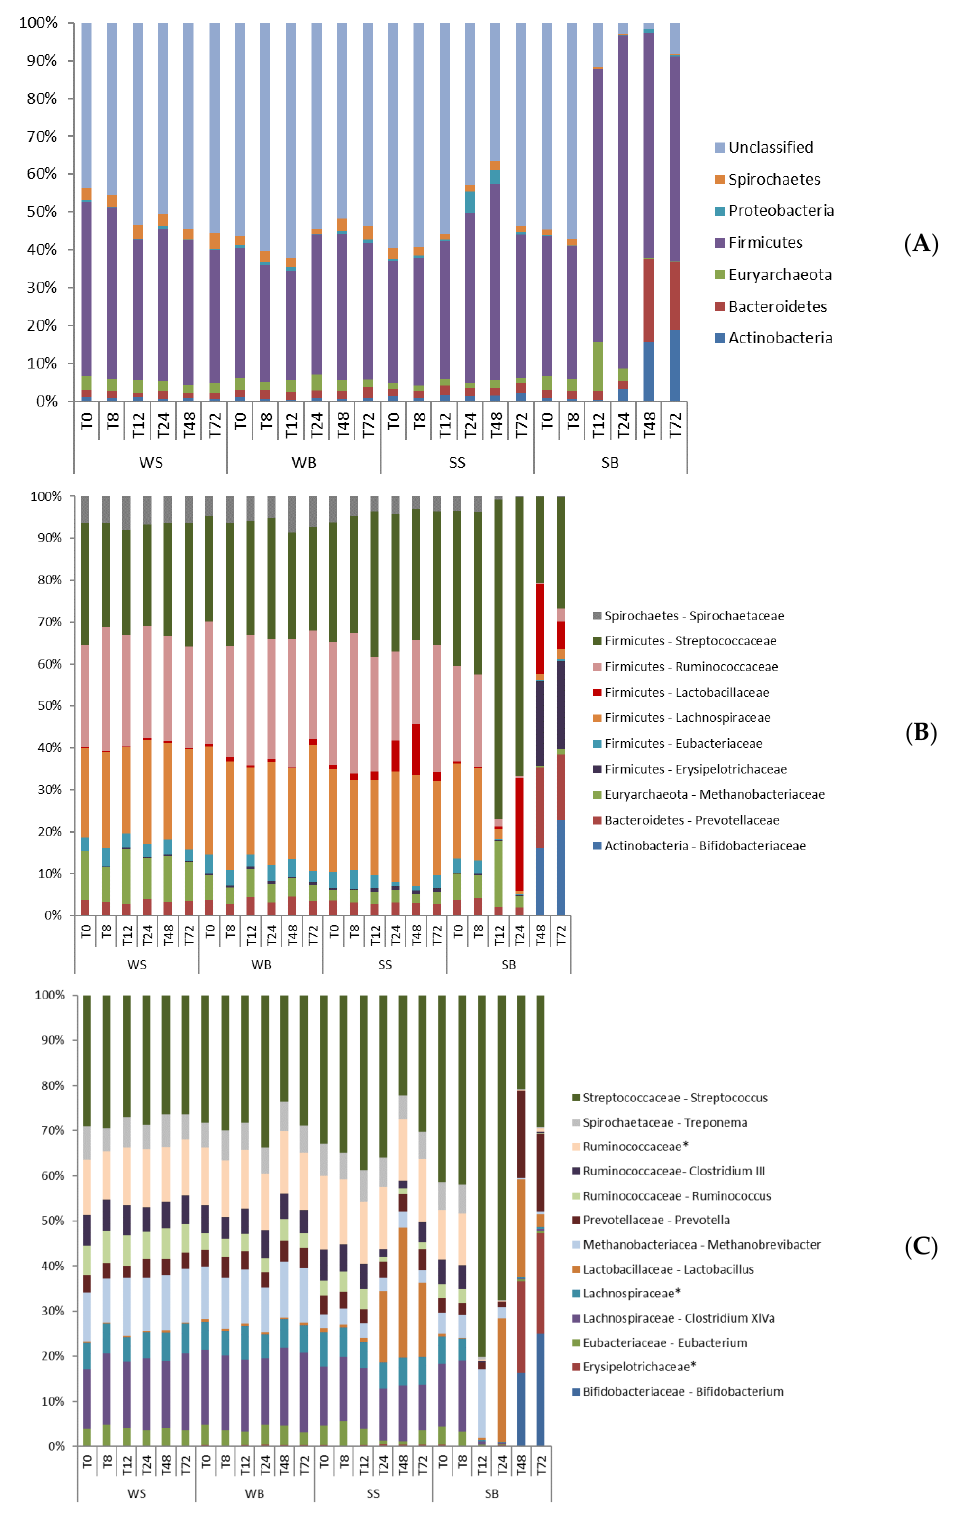
Figure 3. Relative abundance of the predominant bacterial communities (>1%) in the fecal samples 72